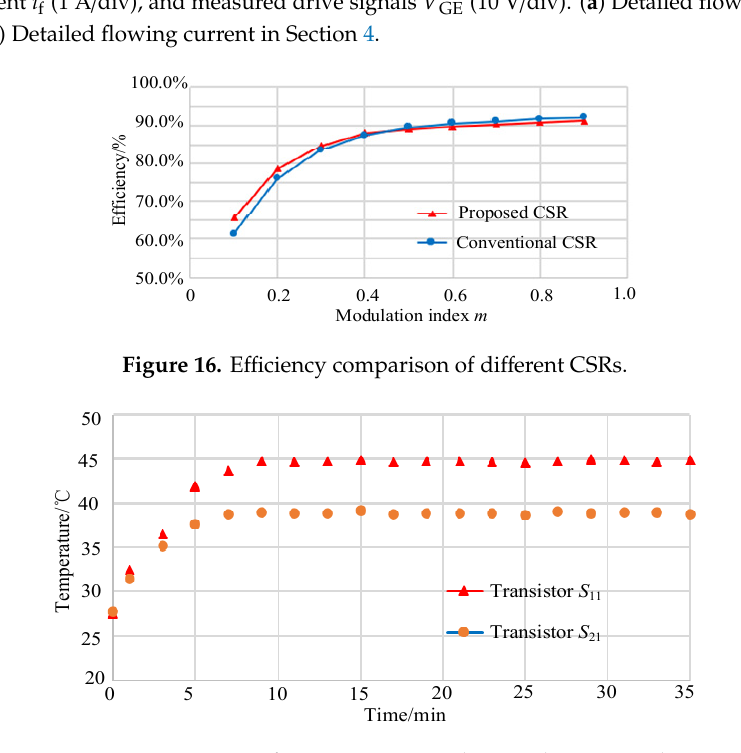
11 and S 21 in the proposed CSR